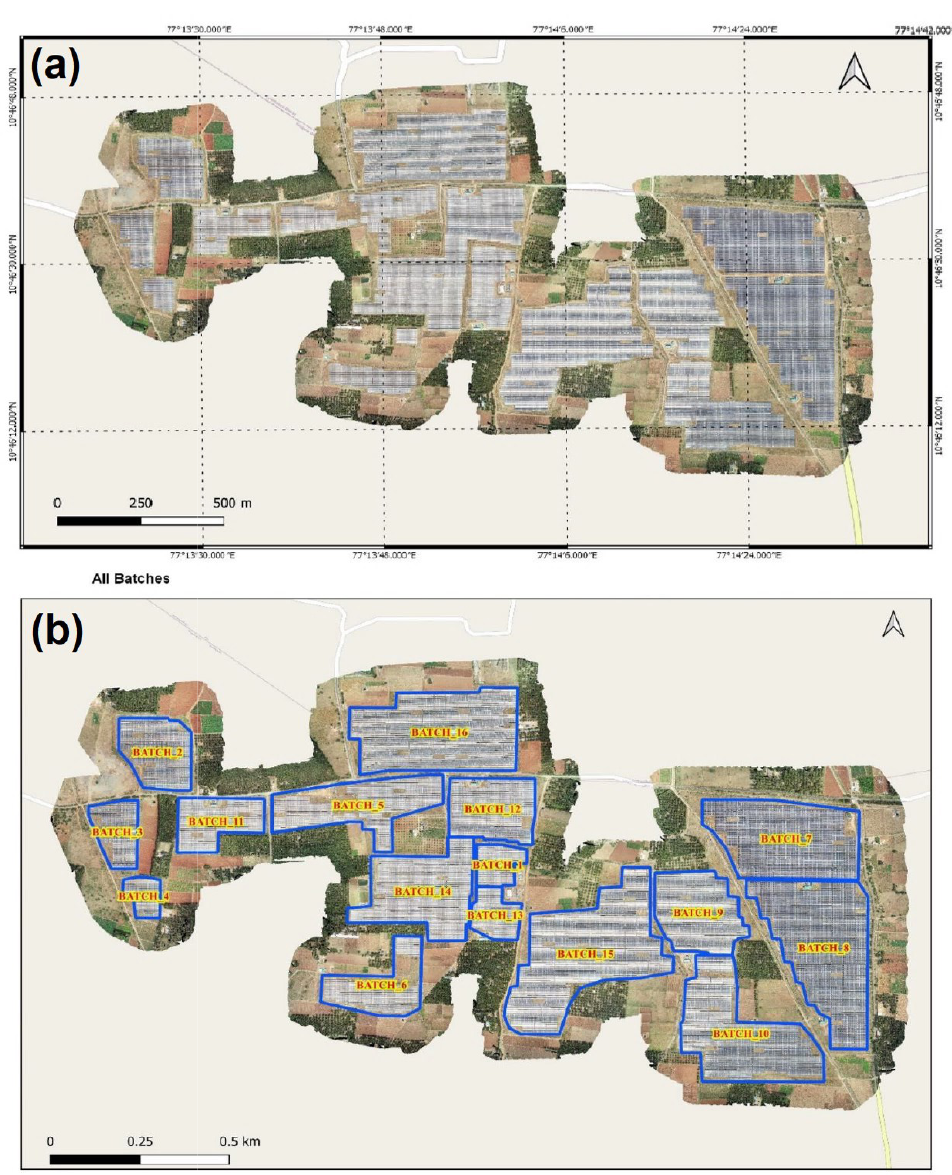
Figure 1. Aerial image of the solar field ( a ) and drone flight pattern ( b ). It is also critical to define flight paths that are divided into two types: so-called “zone paths” and “waypoint paths”. Grid runs, as their name suggests, follow a grid pattern. Their preferred use is in mapping missions that aim to collect imagery for processing into 2D and 3D data products (Figure 2). On the other hand, the paths of waypoints follow an undefined pattern that results from the unique characteristics of each area of interest where the flight takes place and are used for linear missions designed which are designed for investigations, project progress monitoring, security issues,